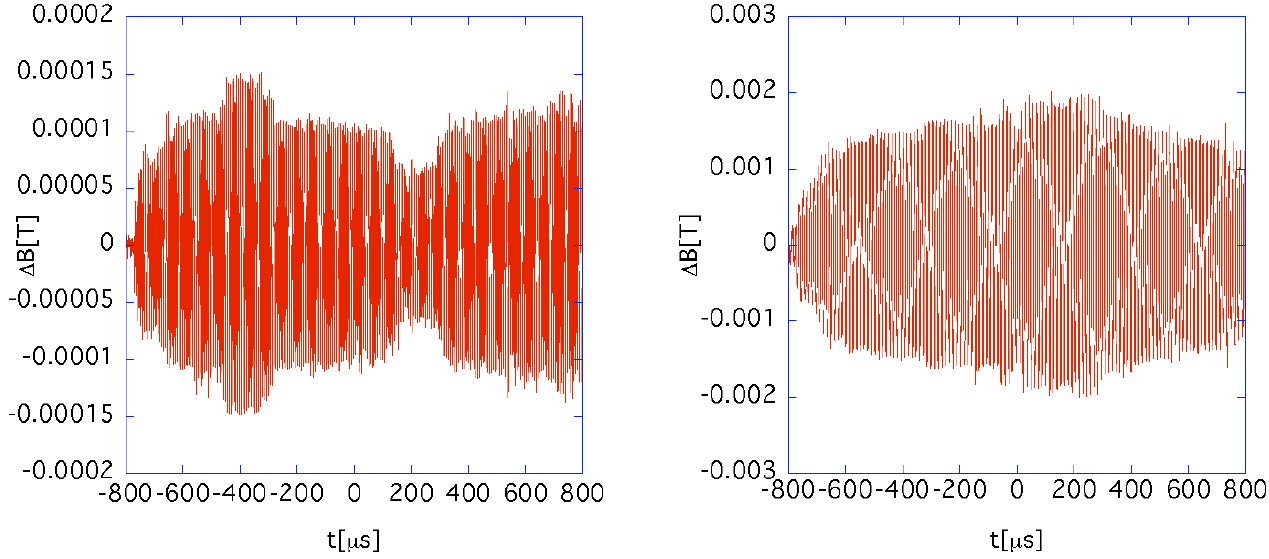
FIG. 28. (Color) The field modulation (theoretical results) due to the traverse of the area enclosed by different stripes by the measured magnetic flux (that is given by the left of Fig. 16). The left figure represents the case where 20 capacitors are working on the lower side of the chamber. The right figure represents the case where all the capacitors ( k ¼ 100 ) are